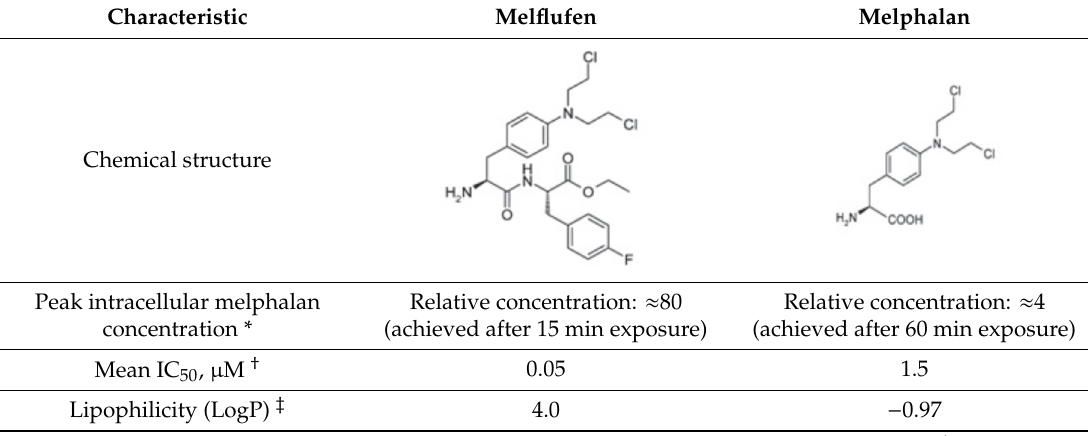
Table 1. Comparison between melflufen and the known alkylator melphalan [30,33,40]. Characteristic